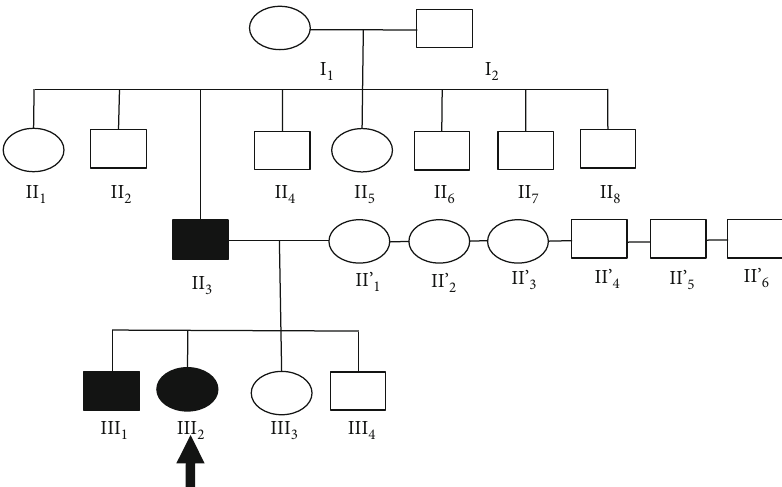
Figure 1: Pedigree of the studied